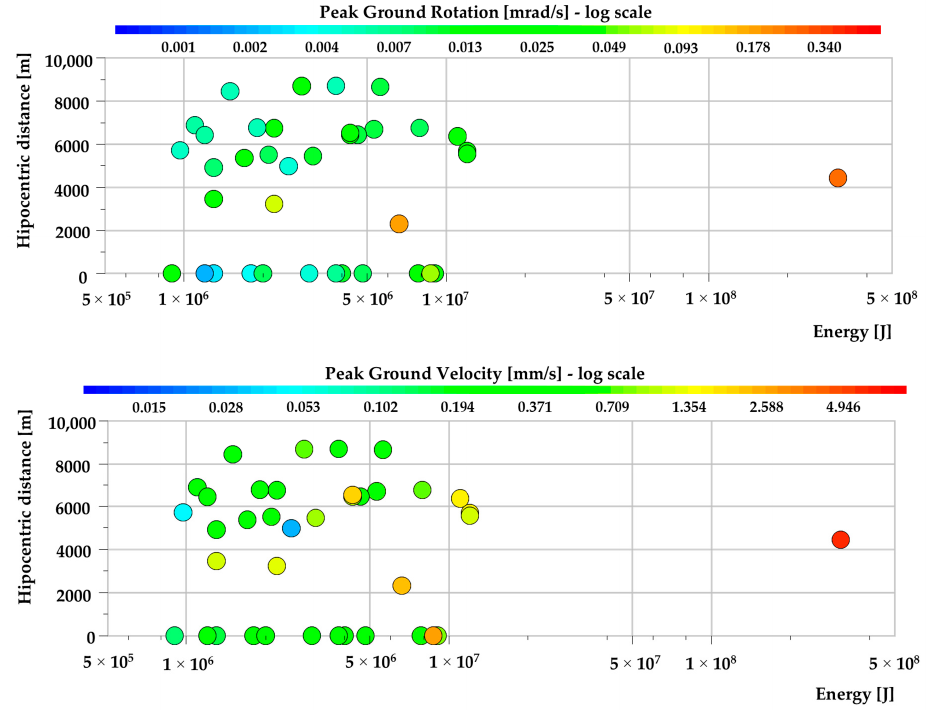
Figure 7 Figure 7. The values of and PG RV ( top ) PG V ( bottom ) recorded at the dam of the Zelazny Most tailing pond.